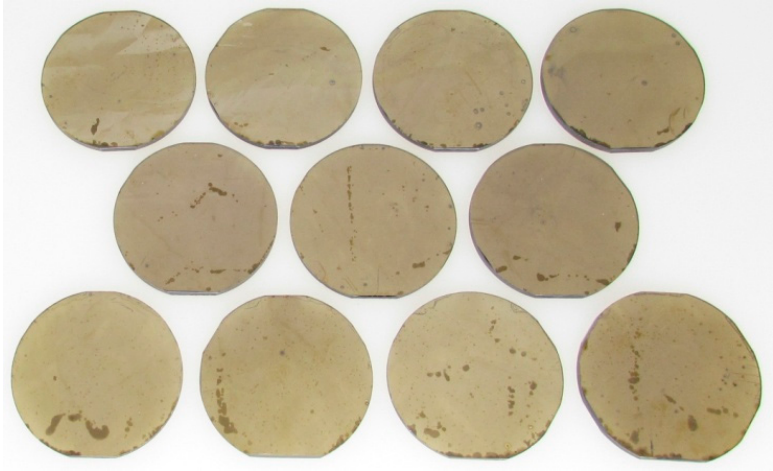
Figure 2. Eleven rounded 2” c -plane GaN boules grown by the NEAT method in a single run.